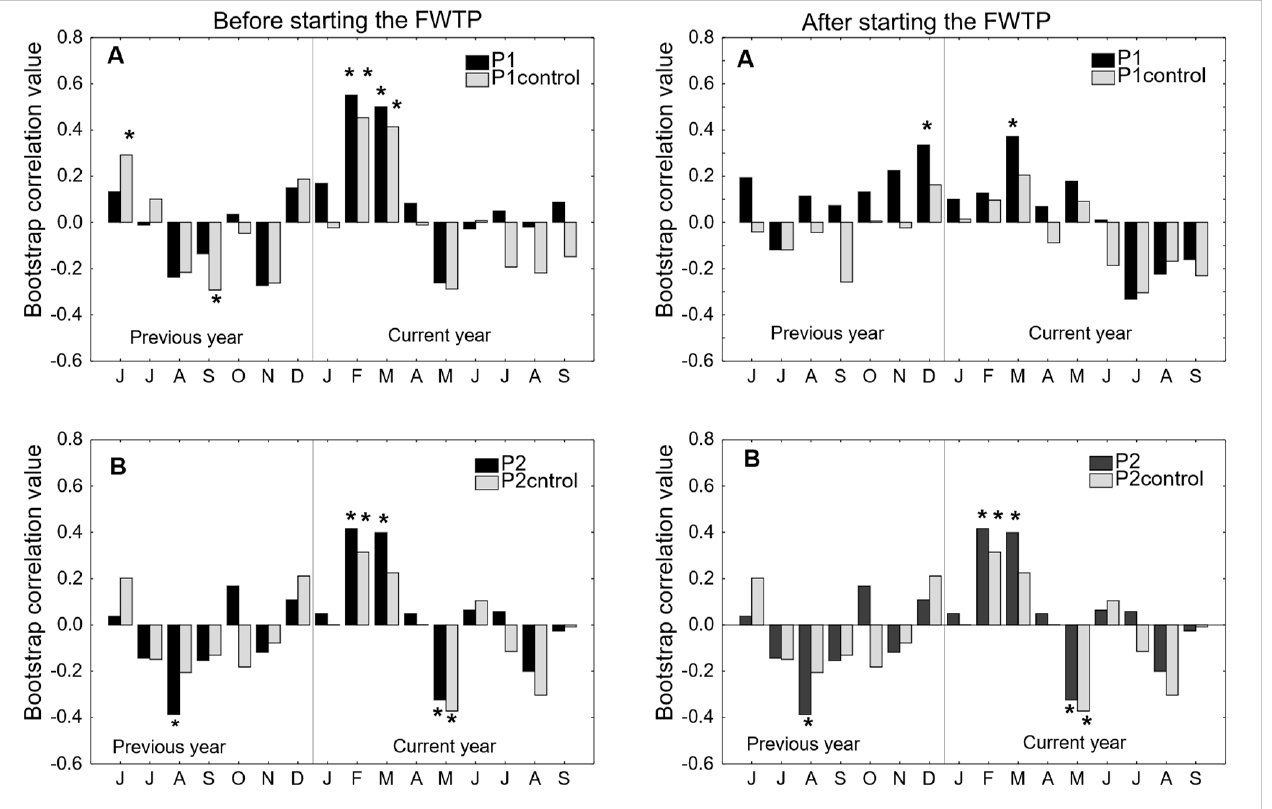
Figure 8. Relationships between air temperature and radial growth of Scots pine growing on the study plots (residual chronologies) for the period before fertiliser application and the period after the starting operation of the Forest Wastewater Treatment Plant. ( A )–plots with younger trees; ( B )–plots with older trees. Asterisks (*) indicate significance at p < 0.05.